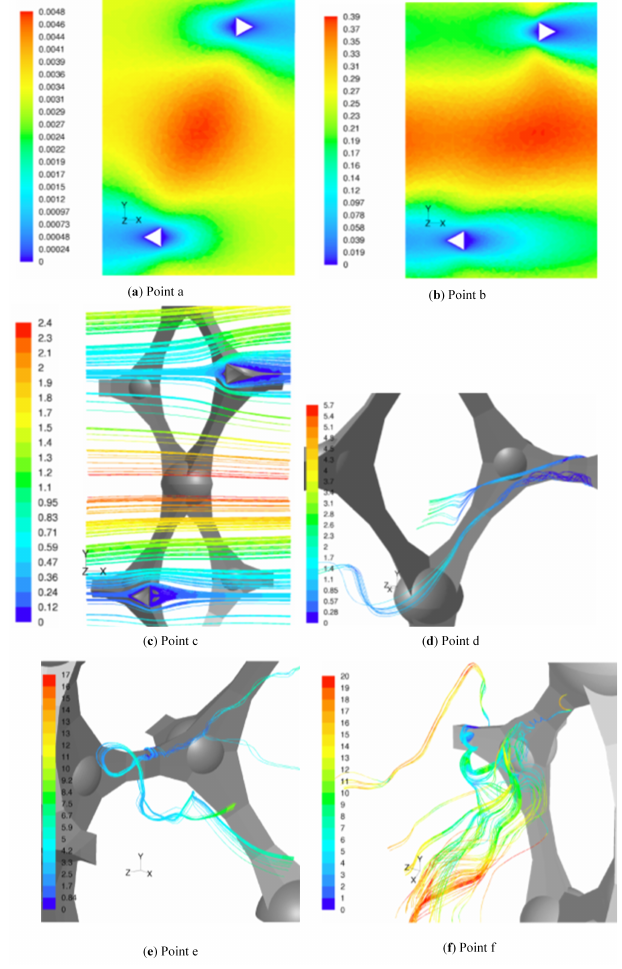
Figure 8. Illustration of the different flow regimes as indicated in Figures 7 and 9. ( a ) Point a: = 0.038; ( b ) Point b: Re Re d s = 105.3; ( f ) Point f: Re ( e ) Point e: Re d s